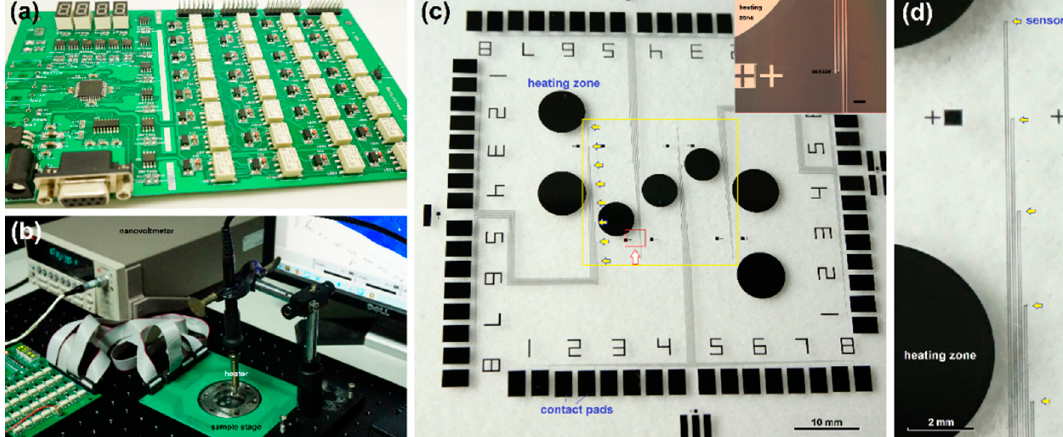
Figure 1. Optical photographs. ( a ) The multiplexer; ( b ) The testing system in a working state; ( c ) A sample with 32 Cr-Pt TFTCs arranged in a 4 × 8 matrix (in the yellow square region). Eight TFTC sensor junctions in the first row are highlighted with yellow arrows. The inset is an enlarged optical microscopy image of one TFTC junction region in the second row marked with a red frame, and the scale bar is 200 μ m; ( d ) An enlarged view of the first row shown in ( c ).